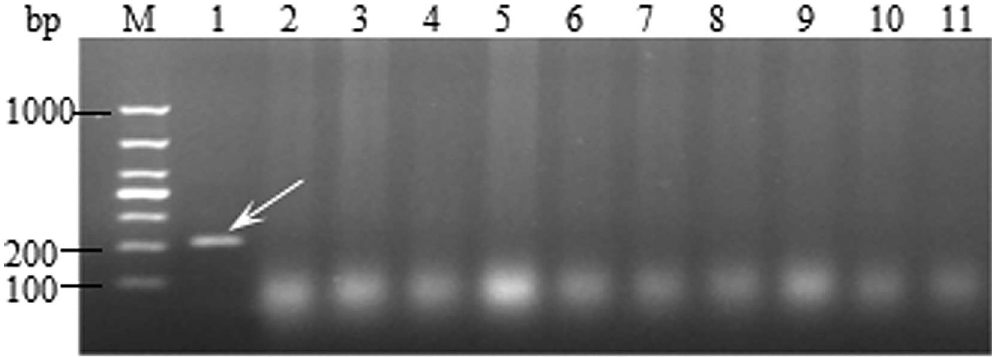
Fig 2. Amplification result for parts of wheat varieties with Sr26#43. Lane 1–11, Monogenic Sr26 , Little Club, Water control, Jingmai 8, Jingmai 9, Jingmai 10, Jingmai 11, Jingmai 12, Jingmai 14, Jing 0202, and Jing 04–6. ‘M’ indicates1000 bp DNA ladder and white arrow indicatesthe position of the specific